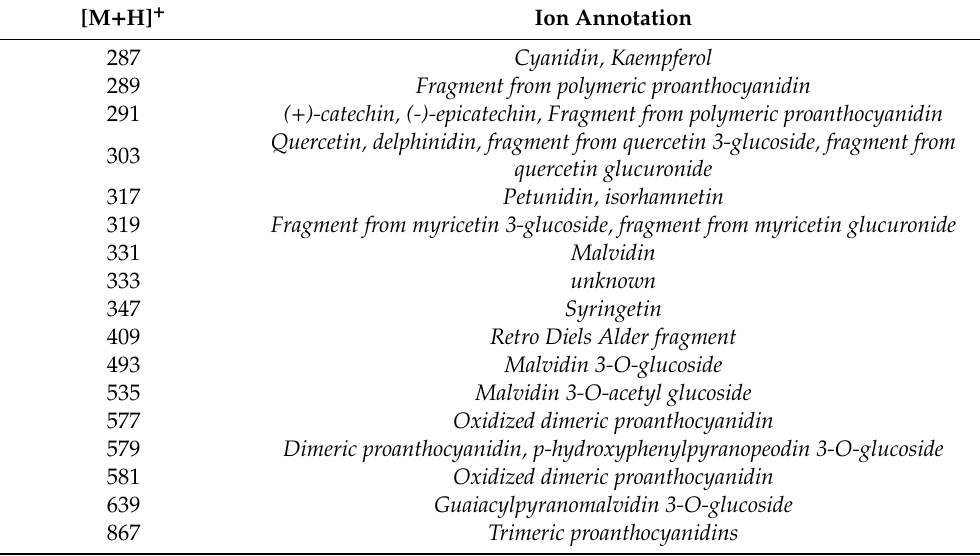
Table 4. Ion annotation in high-resolution MS